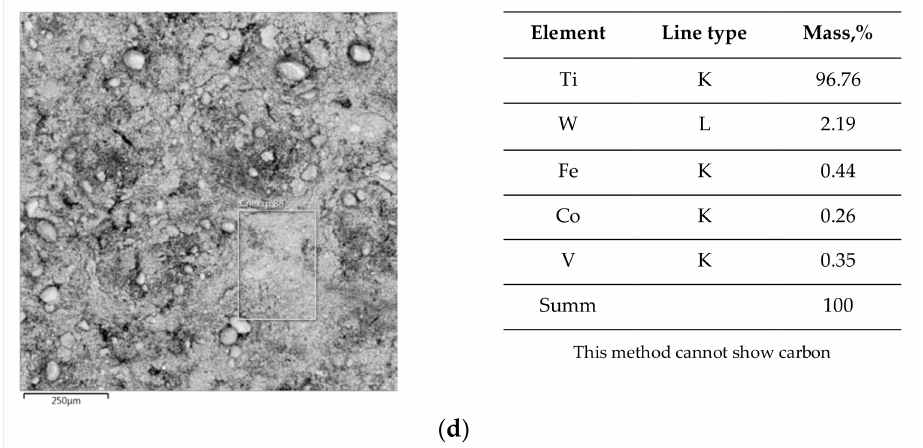
Figure 3. The EDS map of the distribution of elements of ( a ) Ni powder; ( b ) Cu powder; and ( c ) Zn powder; and ( d ) X-ray fluorescence analysis results of the TiC powder.